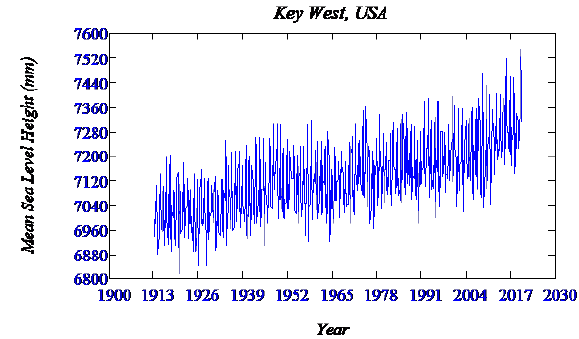
Fig. 2. Monthly averaged mean sea level heights at Key West, USA, TG